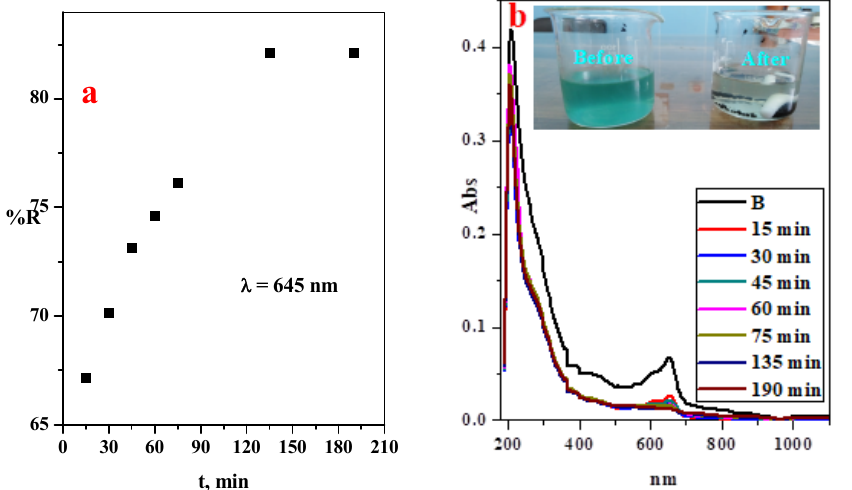
Figure 11. ( a ) Effect of contact time on the adsorption percentage of real sample dye using GO@CS composite beads and ( b ) the UV-Vis spectrum of the MB-dye from real sample at different contact time with GO@CS composite beads, inset photographic image of the factory dye before and after the treatment processes.